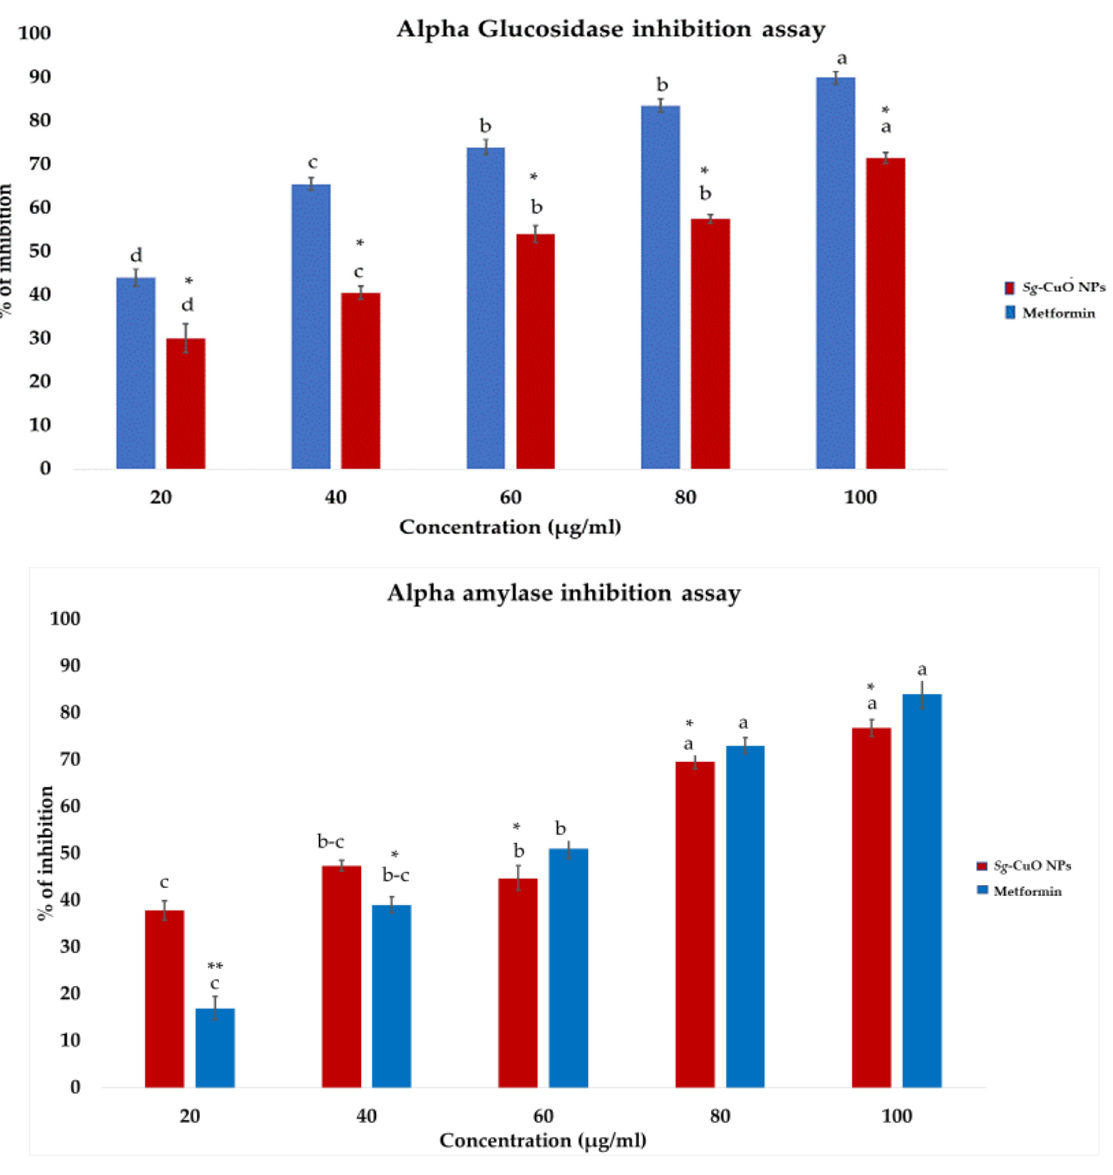
Figure 6. α -glucosidase and α -amylase inhibitory activity of Sg -CuO NPs (20–100 µ g/mL) and the standard drug metformin (20–100 µ g/mL). Values expressed in mean ± SD, ANOVA followed by Tukey’s post hoc, which showed a significant level p -value * < 0.001, ** < 0.05 (Lowercase